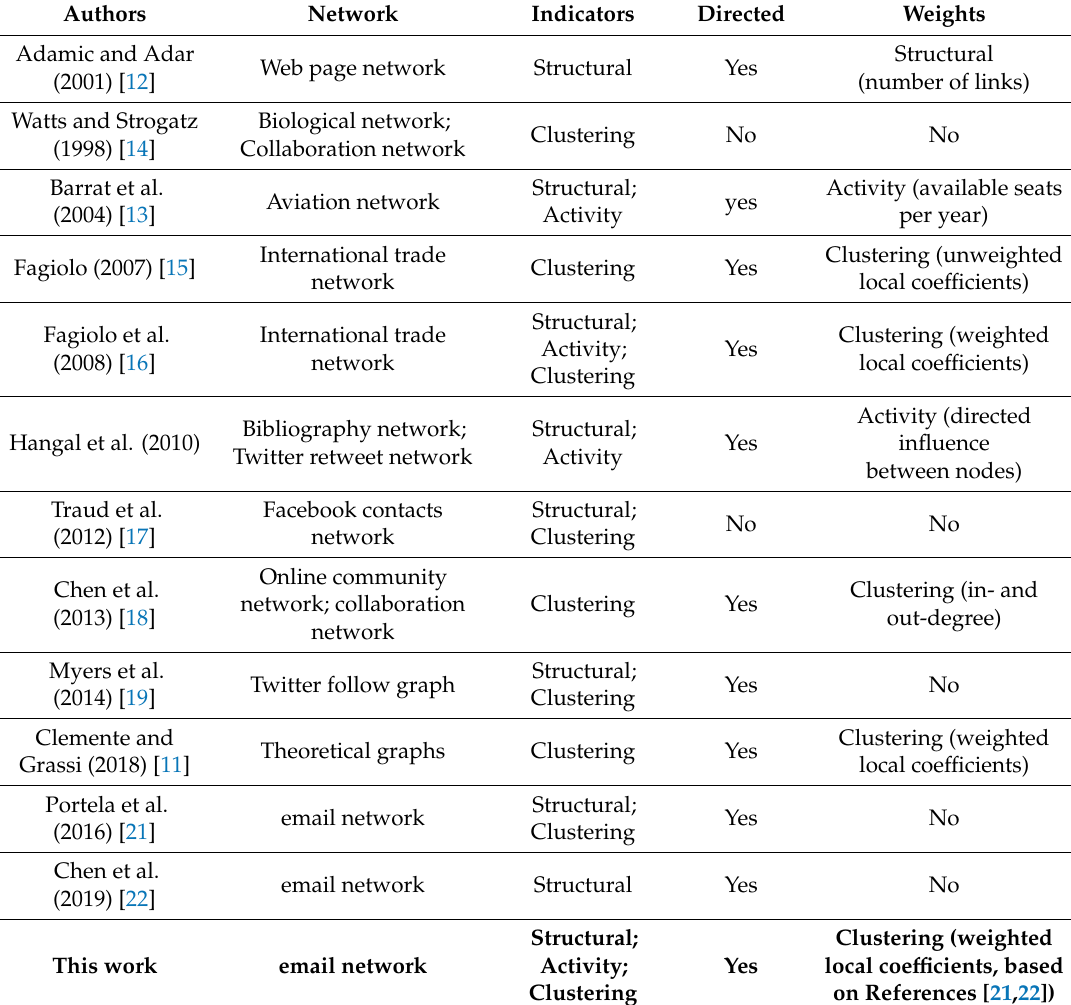
Table 1. Comparison of related literature with present